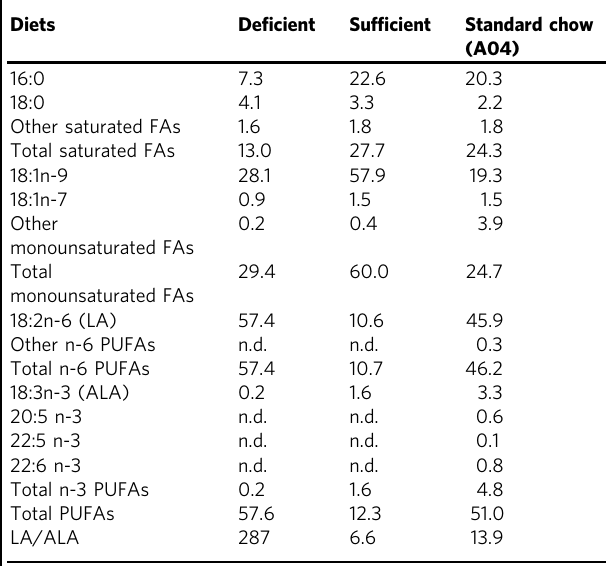
Table 2 Fatty acid composition of the diets (% wt of total fatty